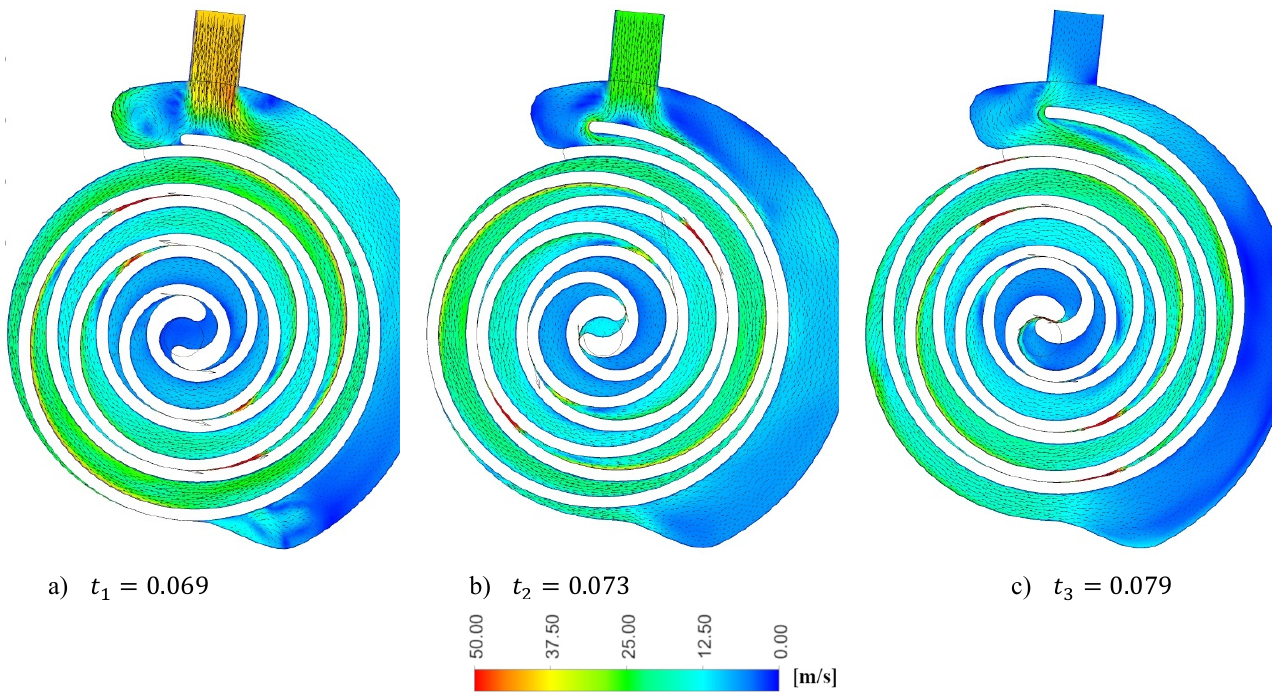
Figure 17. Vector plots of the flow field at mid-span for three different instants during the last revolution (CFX with axial gap).